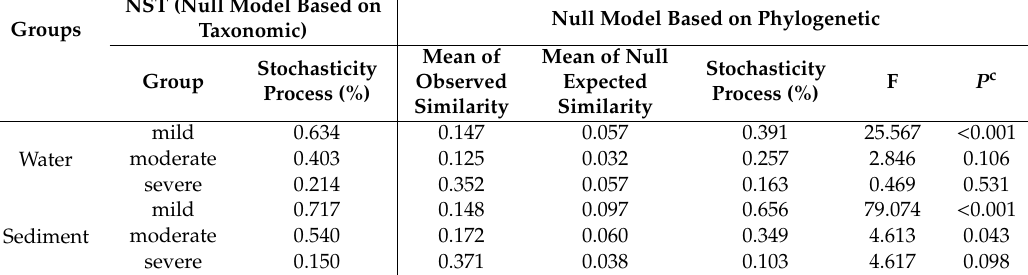
Table 5. Normalized stochasticity ratio (NST) based on Jaccard distance about the bacterial community structure and significance test of the similarity between the microbial communities and null model simulations in three groups of